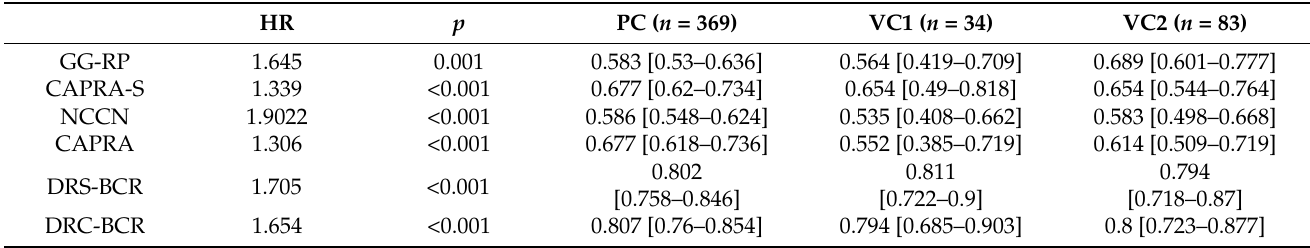
Table 2. Patient characteristics.